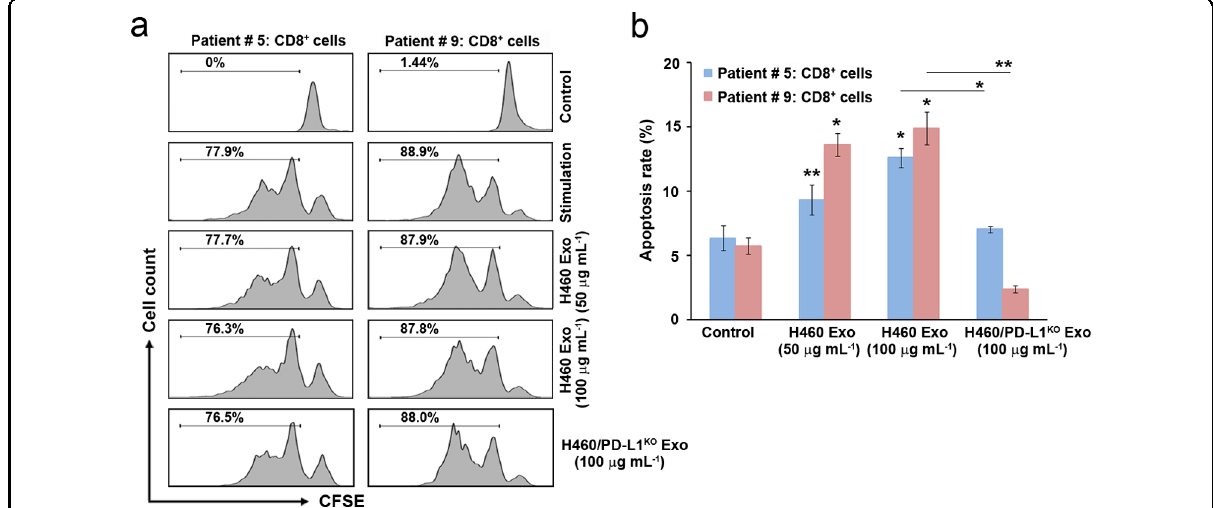
Fig. 6 Induction of apoptosis by PD-L1-positive exosomes. a CD8 + T cells (from patients #5 and #9) were labeled with 2.5 μ M CFSE and cultured with H460 cell-derived exosomes or H460/PD-L1 KO cell-derived exosomes in the presence of 10 μ g mL – 1 anti-CD3, 2 μ g mL – 1 anti-CD28, and 2 μ g mL – 1 anti-IL-2 for 72 h. b CD8 + T cells were incubated with H460 cell-derived exosomes or H460/PD-L1 KO cell-derived exosomes for 24 h and then double stained with Annexin V-FITC (1 μ g mL – 1 ) and propidium iodide (50 μ g mL – 1 ). Analyses were performed using a FACScan fl ow cytometer. All data are presented as the means ± standard deviations. * P < 0.05 and ** P < 0.005 by a paired two-tailed Student ’ s t